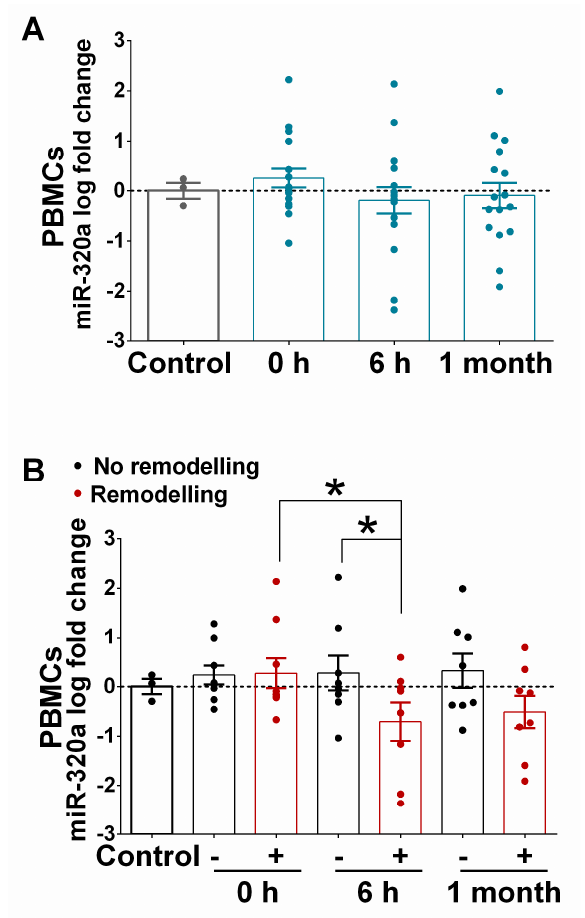
Figure 7. Expression of miR-320a in peripheral blood mononuclear cells (PBMCs) of patients with or without left ventricular adverse remodelling. ( A ) Bar graph shows miR-320a expression in PBMCs of STEMI patients ( n = 20) at 0 h, 6 h and 1 month post PPCI relative to the control ( n = 8). ( B ) Bar graph shows the levels of miR-320a in PBMCs at 0 h, 6 h and 1 month after PPCI in STEMI patients who developed LVAR (red bar, n = 11) or not (black bar, n = 9). Values in the graphs represent the fold change in logarithmic scale for each miRNA relative to the controls. Data are the means ± SEM. Significance is indicated by (*) for p < 0.05. Kruskal–Wallis test with multiple comparisons corrected by Dunn’s test was performed.